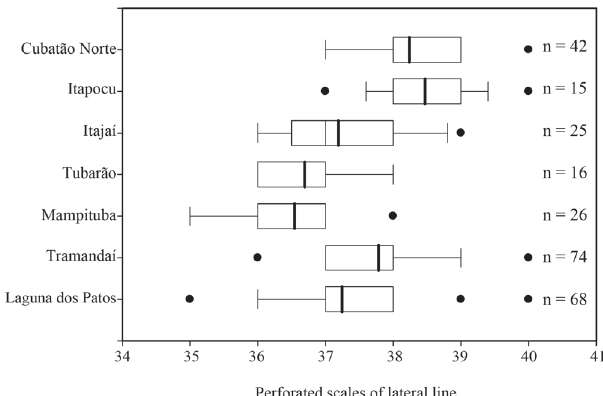
Fig. 9. Tukey box plots of number of perforated scales of lateral line in Astyanax laticeps populations by river drainage from south to north. Mean represented by thick vertical bar and 25 th and 75 th percetiles as lateral borders of box plots.